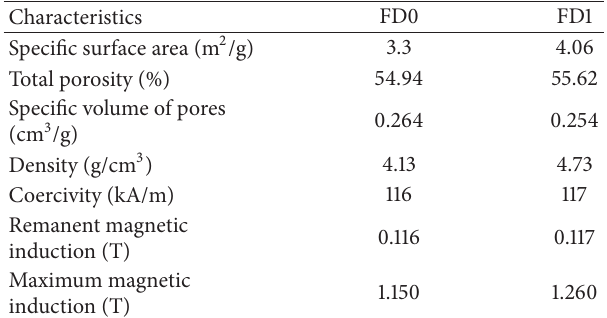
Table 1: Characteristics of strontium